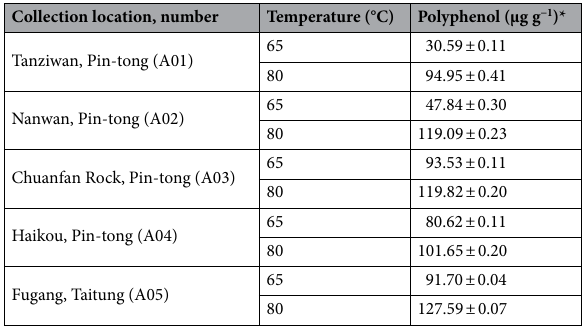
Table 3. The polyphenol yield of fucoidan. *Each value represents the mean ± SD of three determinants of the obtained fractions.